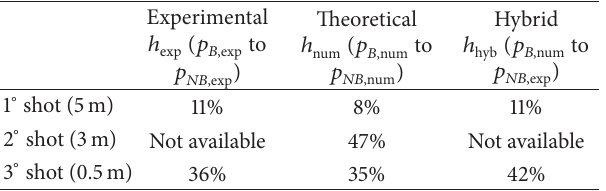
Table 4: Experimental and theoretical peak pressure reduction factors.